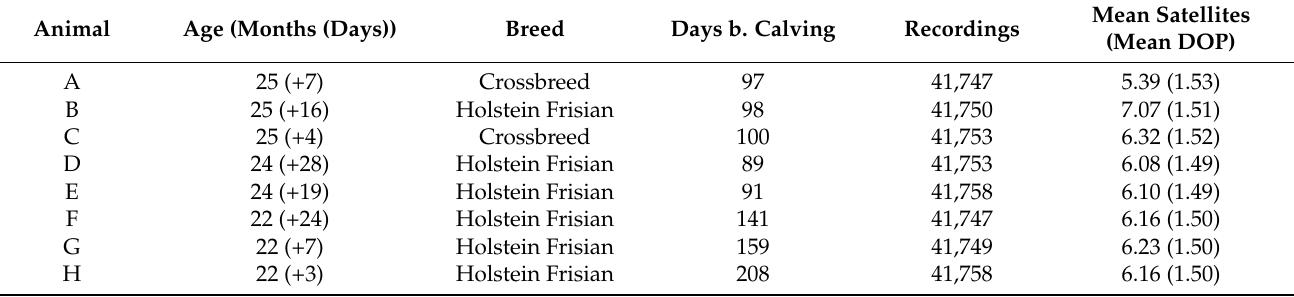
Table 1. Overview of the heifers of the study. Each heifer received an capital letter for individual identification. All heifers were pregnant. The age and days before calving were determined by 24 September 2019 (study start) as the reference date. The column Recordings gives the number of GPS recordings per animal. The animal position was tracked with one-minute resolution. Observing the animals for 29 days, 1440 × 29 = 41,760 data points were recorded per animal without the loss of data points. The last column contains the mean number of satellites used for position estimation, as well as the mean dilution of precision (DOP).